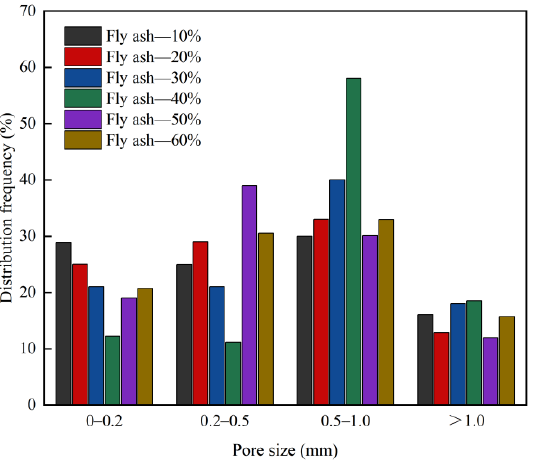
Figure 10. Effect of fly ash content on the porosity of foam concrete.